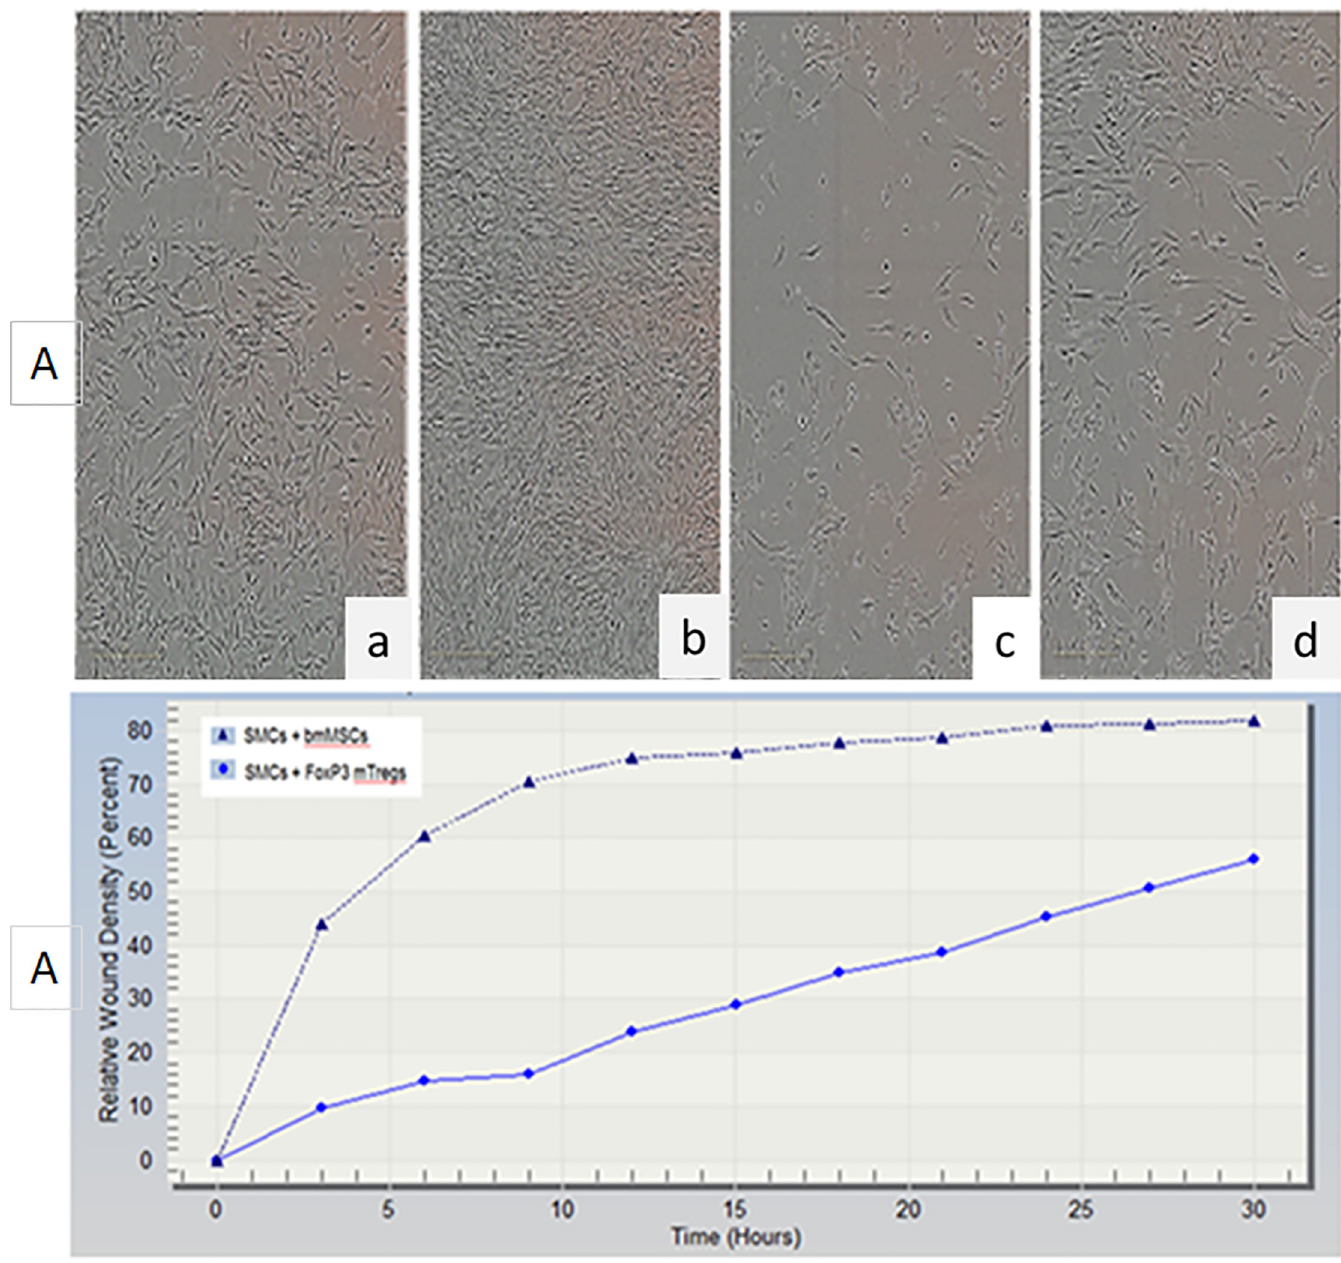
Fig 4. FoxP3+ mTregs inhibit cell migration, invasion and relative wound density (RWD) in injured human smooth muscle cells (hSMCs). hSMCs were treated with MSCs [4A (a, start 3hrs; b, end 30hrs)] or FoxP3+ mTregs [4A (c, start 3hrs; d, end 30hrs)]. FoxP3+ mTregs inhibit RWD in injured hSMCs (4B) and S2 Data.